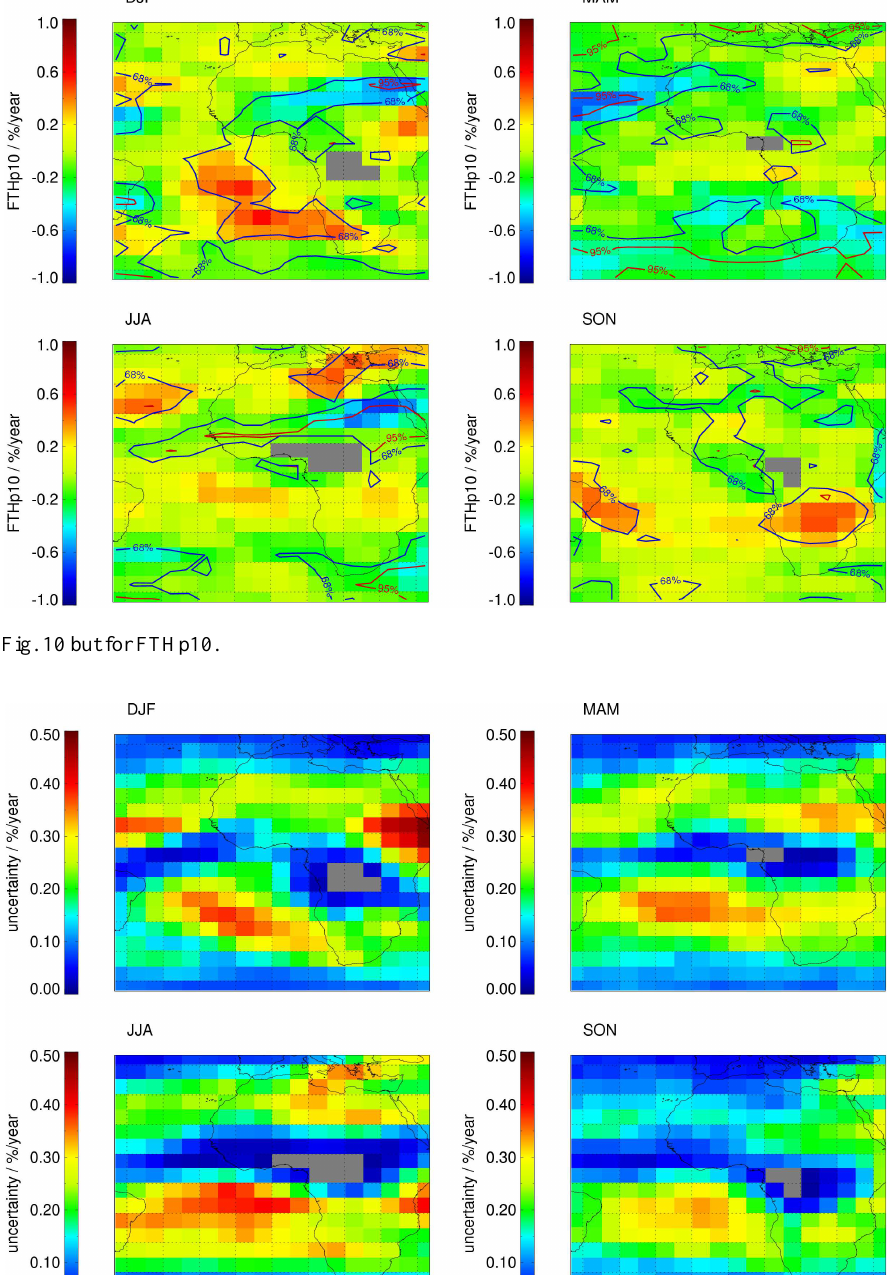
Figure 13. Same as Fig. 11 but for the uncertainty of the linear trend in FTHp10. 2